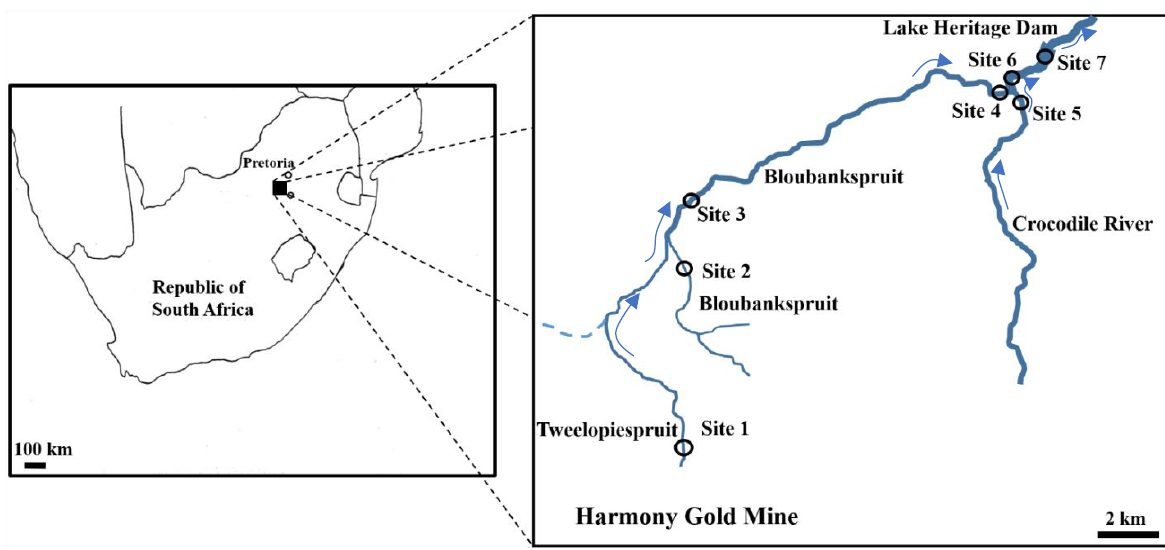
Figure 1. The Republic of South Africa with a black square indicating the sampling area. Black rings specify the sampling sites 1 – 7. Table 1. Coordinates of sampling sites and information on the respective rivers at each site.